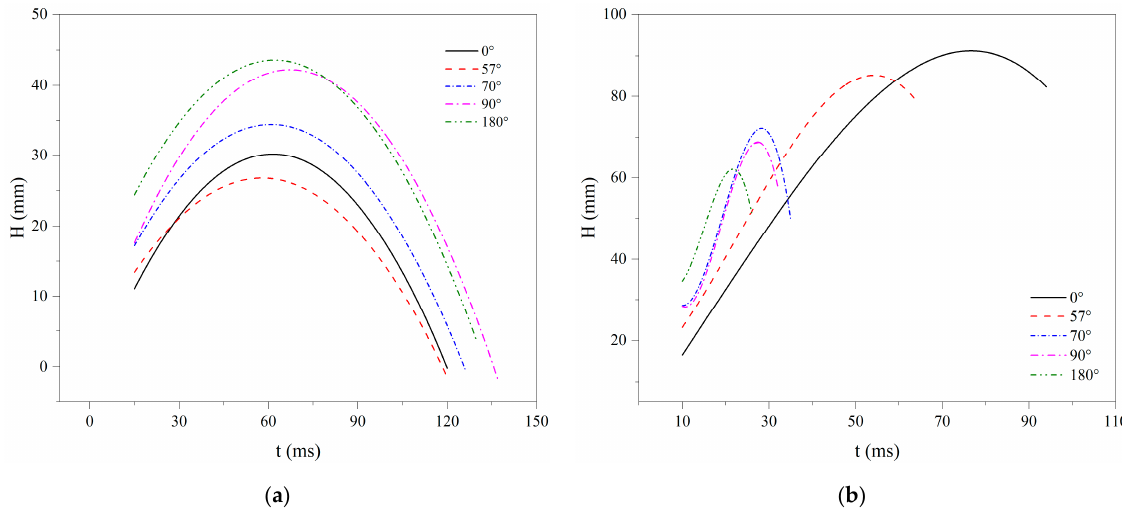
Figure 19. The splash height–time curve of the hydrophobic model. ( a ) The initial velocity v = 2.2 m/s. ( b ) The initial velocity v = 3.95 m/s. In the initial splash stage, at both speeds, the larger the head shape’s hemispherical angle is, the larger the splash height is. As for the maximum splash height at 2.2 m/s, basically, a larger head hemispherical angle produces a greater maximum splash height. At 3.95 m/s, basically, the larger the head shape hemispherical angle is, the smaller the maximum splash height is. This is because the entire development time of the splash is short, and the splash cannot be extended upward to the necessary extent. Similarly, the splash closure height is related to the way in which it is closed, and the closure height above the model is the same, and the closure height on the surface of the model is the same. When the speed is 2.2 m/s, the time required for different head shapes to reach the maximum splash height ranges between 50–60 ms, and the time for the splash to fall to the water surface ranges between 120–140 ms. At 3.95 m/s, with a larger hemispherical angle of the head shape, the splash reaches its maximum height, and the upper end of the splash closes faster. As for the splash diameter, since the processes of the change in the shape of the splash at the two speeds are completely different, the processes of the change in the splash diam- eter with time are also completely different. At 2.2 m/s, except for the 180° hemispherical angle condition, the development trend of the diameter is basically similar, and the splash continues to expand slowly after the initial rapid expansion. For the 180° hemispherical angle condition, when the shape of the splash changes into a truncated cone, the diameter of the upper part decreases. After the diameter is reduced for a period, as the splash falls, the overall diameter increases rapidly. At 3.95 m/s, basically, the larger the head shape hemispherical angle is, the smaller the splash diameter is and the earlier the splash closes. Figure 20 shows the splash diameter over time.